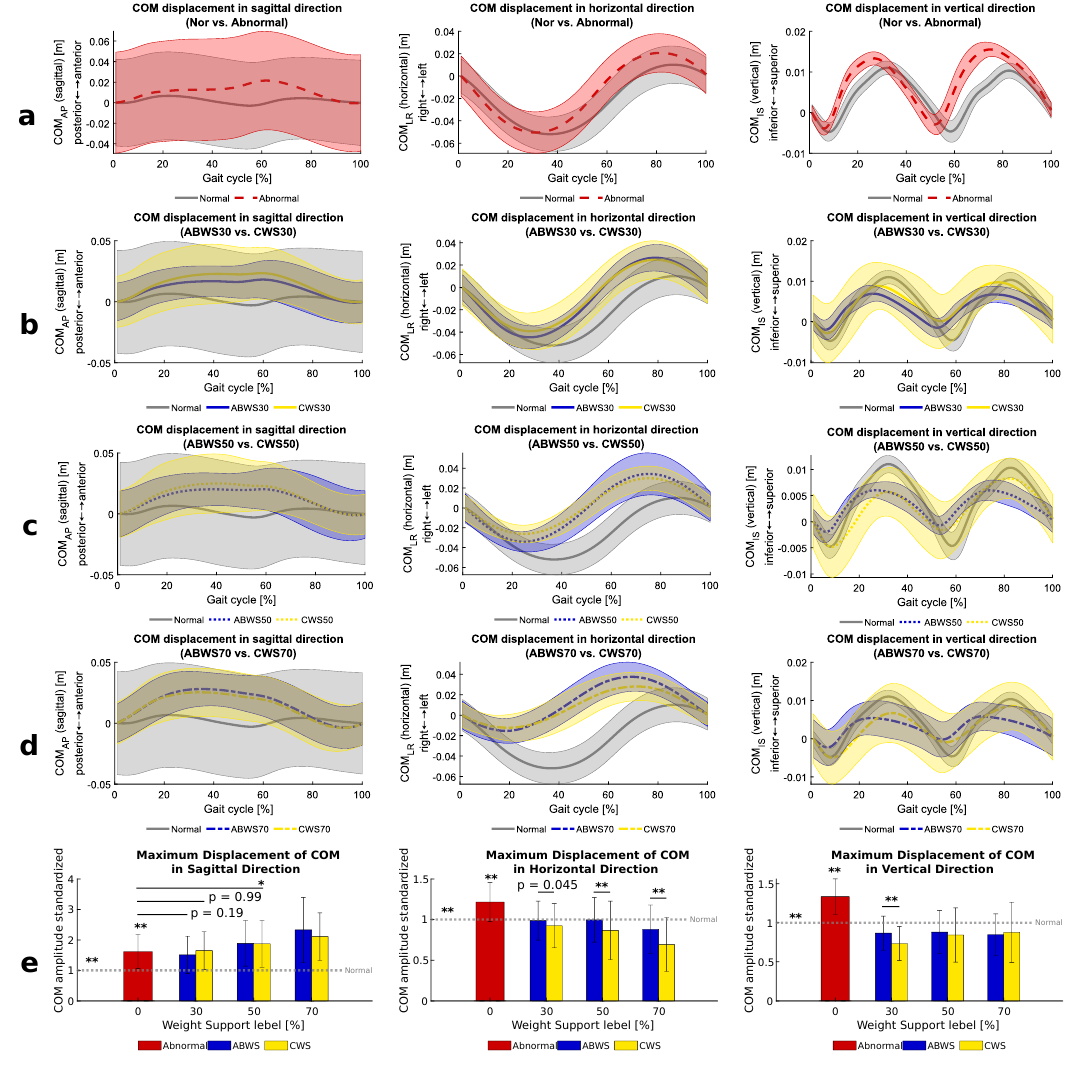
Figure 5. Comparison of the COM trajectories: normal vs abnormal walking ( a ), ABWS and CW system unload 30% ( b ), ABWS and CW system unload 50% ( c ), ABWS and CW system unload 70% ( d ). ( e ) showed the comparison of the maximum displacement of COM in sagittal, horizontal and vertical direction. The significant value ( p ) was selected as 0.05. * and ** show that p is less than 0.01, and 0.001,